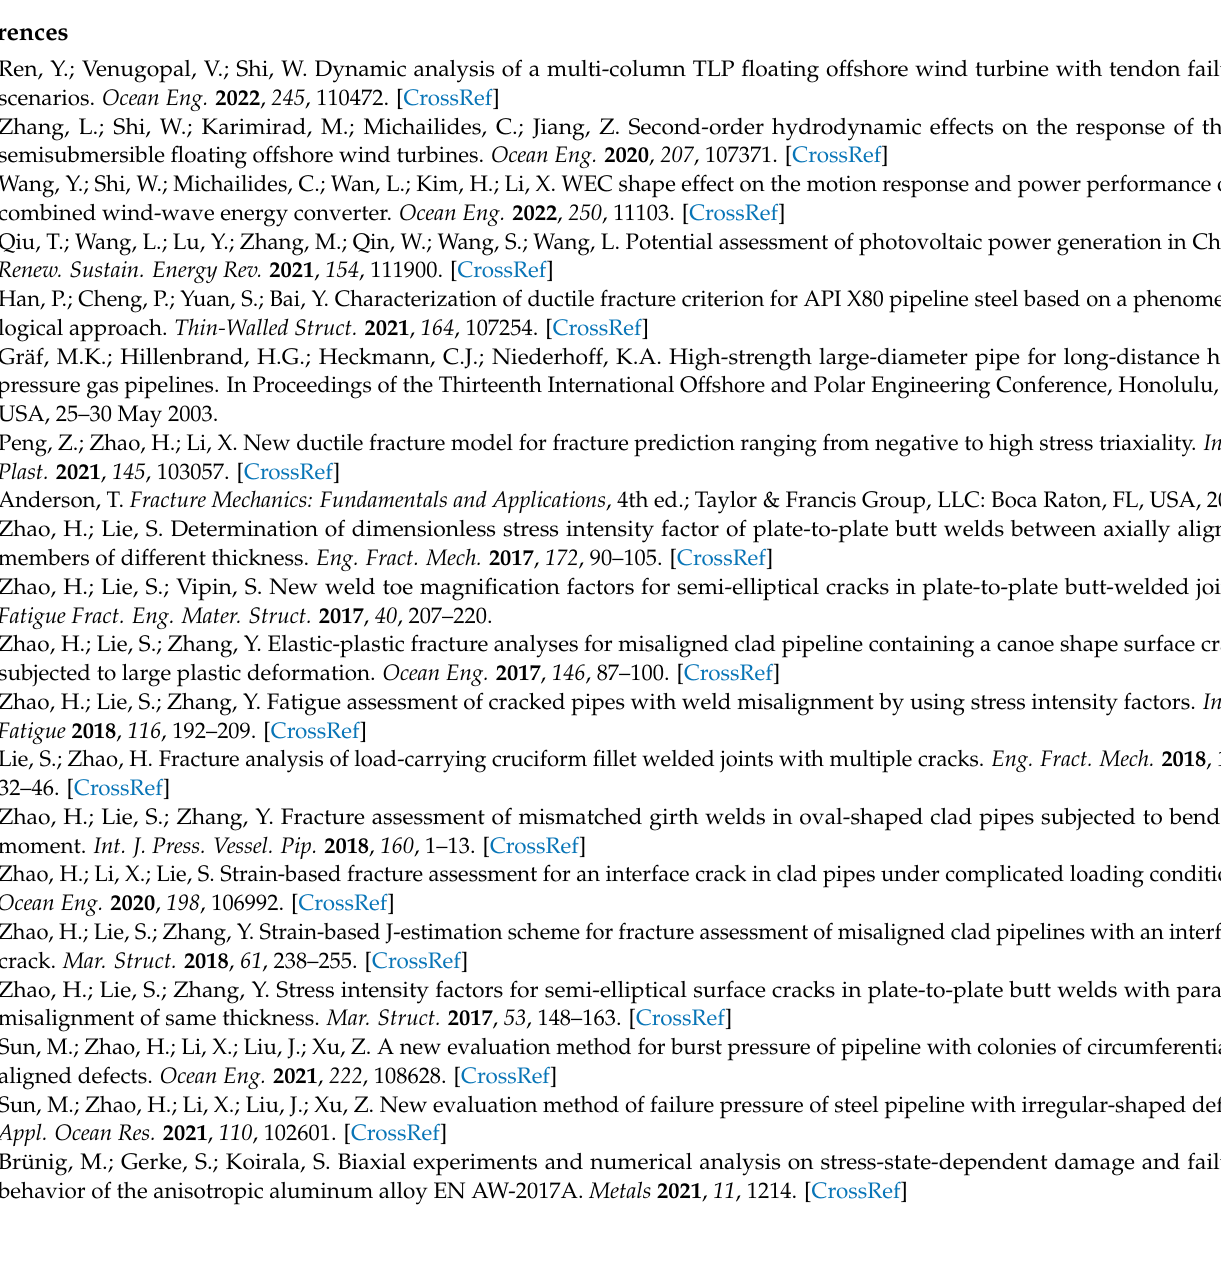
The fracture of the shear-tension specimen initiates at the center of the groove and propagates to the edge of the section. The initiation of fracture is identical to the testing